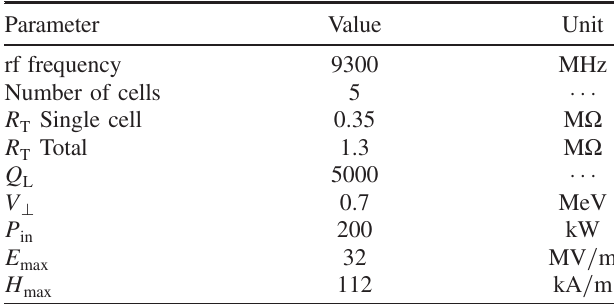
TABLE II. rf deflector